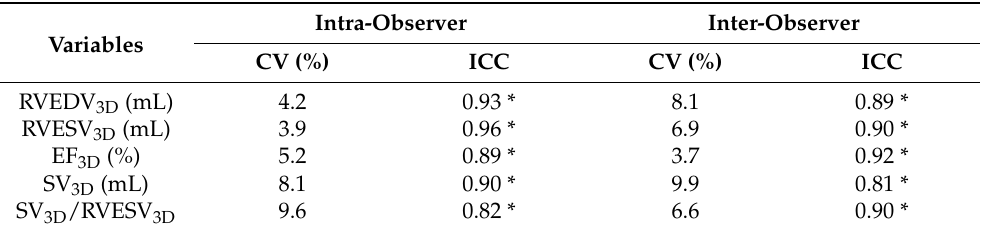
Table 4. Results of the intra- and inter-observer measurement variabilities in real-time three- dimensional echocardiography